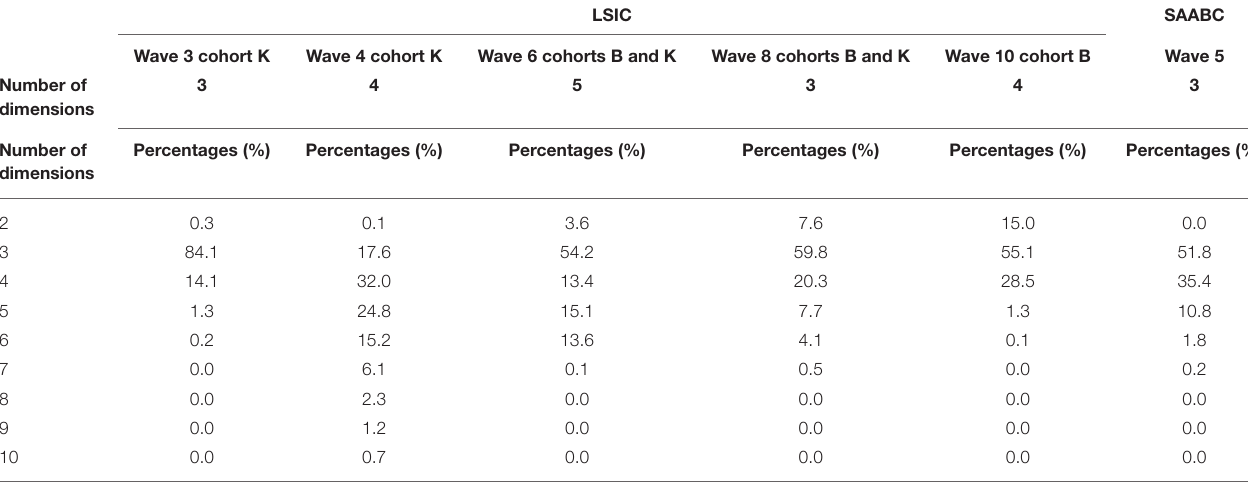
TABLE 2 | Number of Strengths and Difficulties Questionnaire (SDQ) dimensions identified by exploratory graph analysis (EGA).